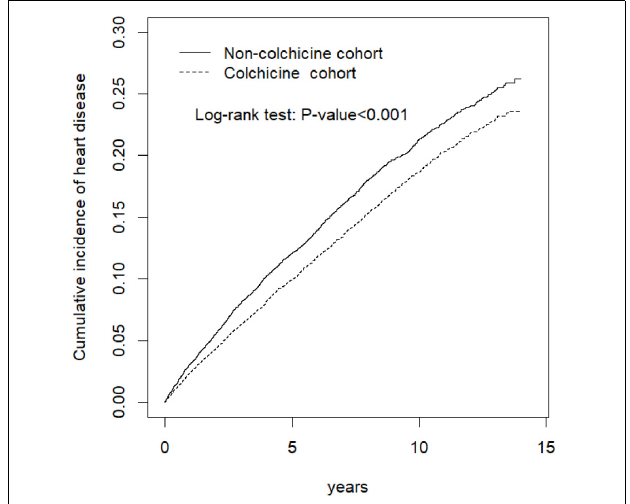
FIGURE 3 | Cumulative incidence of heart disease curves for colchicine users and colchicine non-users by propensity score